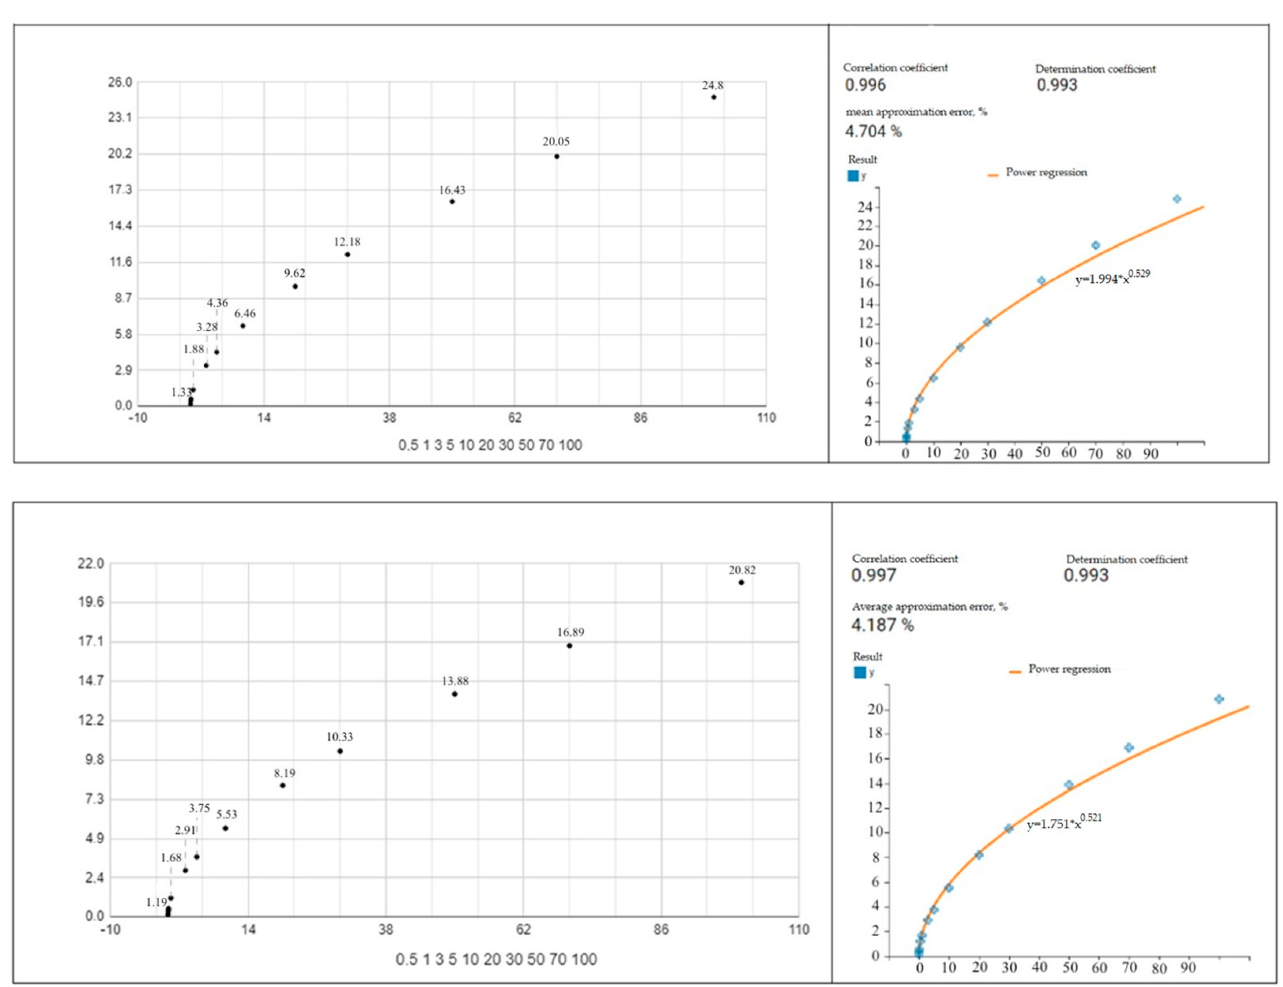
Figure 12. Approximating dependences for each wind speed, where the OX axis is the equivalent amount of PPS, and OY is the depth of the contamination zone.